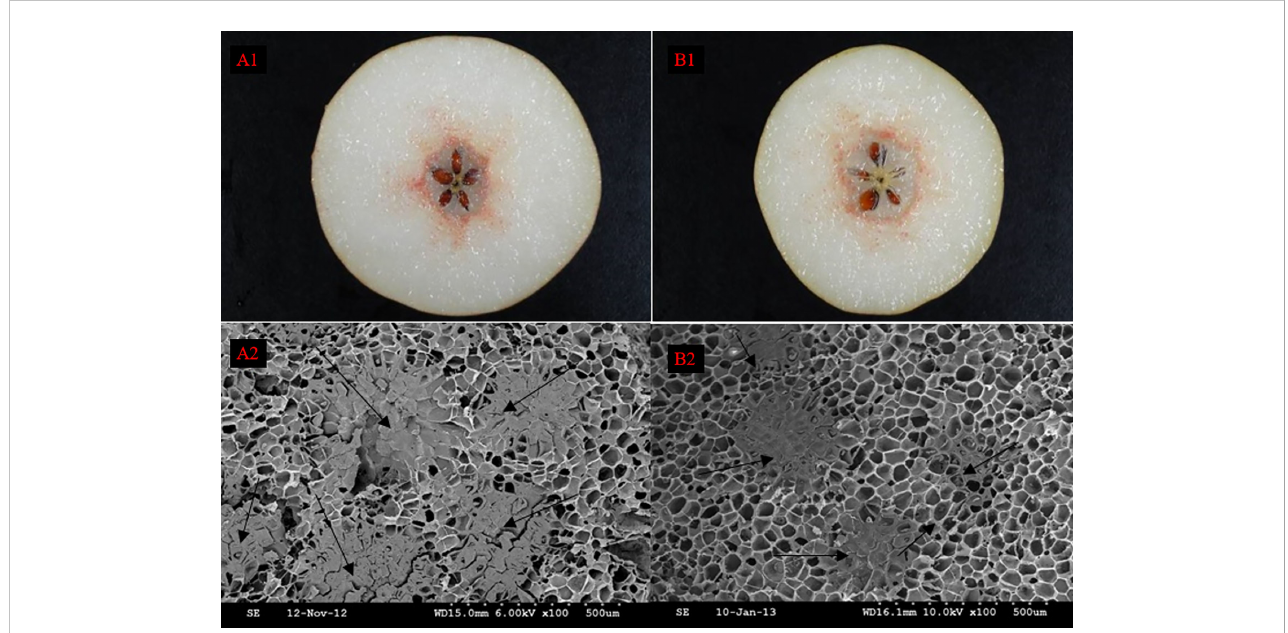
FIGURE 1 The distribution of stone cell cluster of DY and DW. A1 Cross section staining of DY, A2 Scanning electron microscopy of DY, B1 Cross section staining of DW, B2 Scanning electron microscopy of